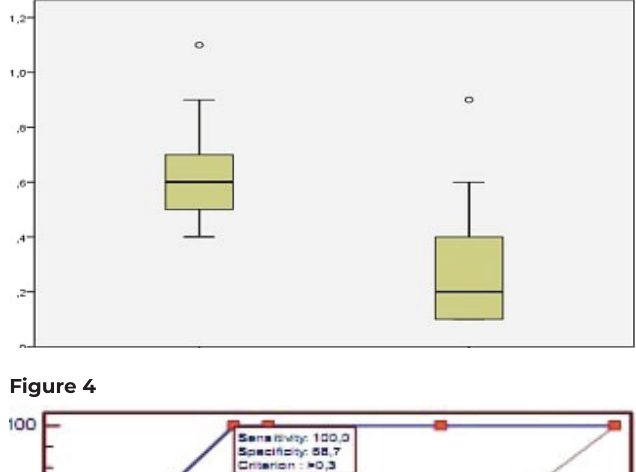
Highest strain index were detected in RCCs. This value differ between malignant and benign lesions significantly. According to M2 method, cut-off value was taken 0.3. For values bigger than 0.3; positive and negative predictive value for detecting malignant lesion were found 80% and 100%, sensitivity and specificity were 100% and 68.7% (p<0.001) (Figure 4). (Area under curve-AUC:0.899). For other values sensitivity and specificity that could detect benign lesions were 68.7% and 100% (p<0.001) (AUC:0.899).